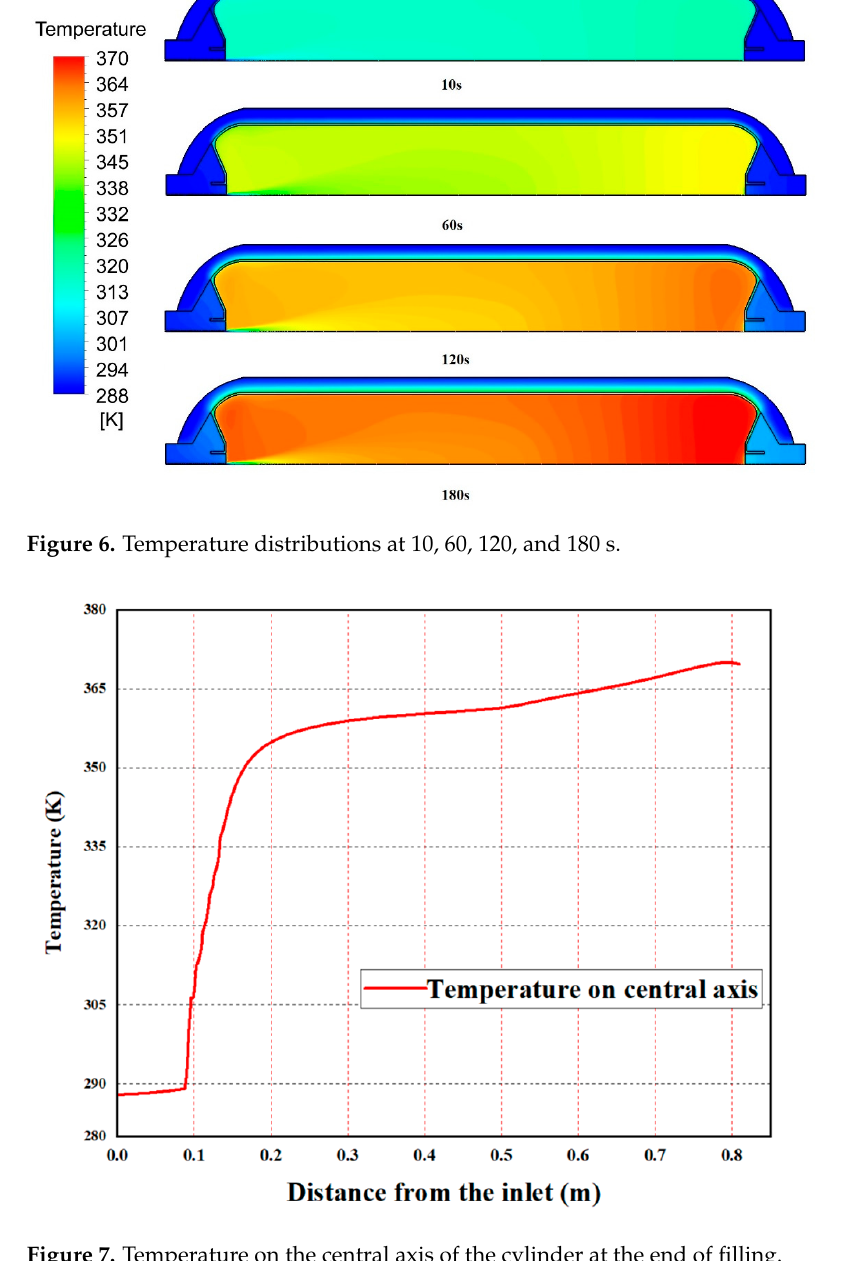
Figure 8. Temperature evolutions of the hydrogen and solid materials. 3.2. E ff ect of Hydrogen Filling Rate The hydrogen fi lling rate is usually expressed as the mass fl ow rate (kg/s) or average pressure rise rate (APRR, MPa/s) [47], where di ff erent hydrogen fi lling rates correspond to various fi lling times. For Cylinder A (24 L), four hydrogen fi lling rates of 0.217, 0.361, 0.542, and 1.083 MPa/s are selected, which correspond to fi lling times of 300, 180, 120, and